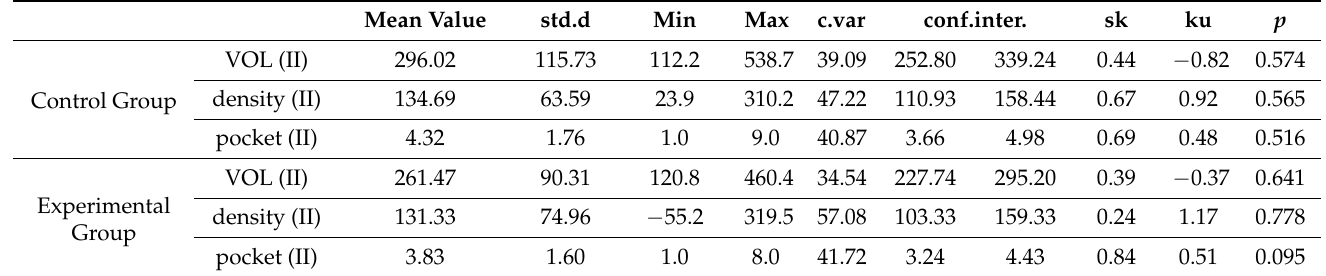
Table 4. Results of II measurement in the control and experimental groups.